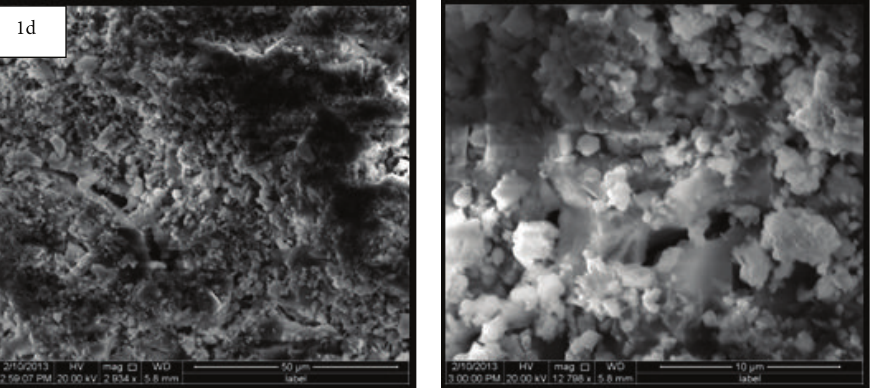
Figure 11: SEM of 1d